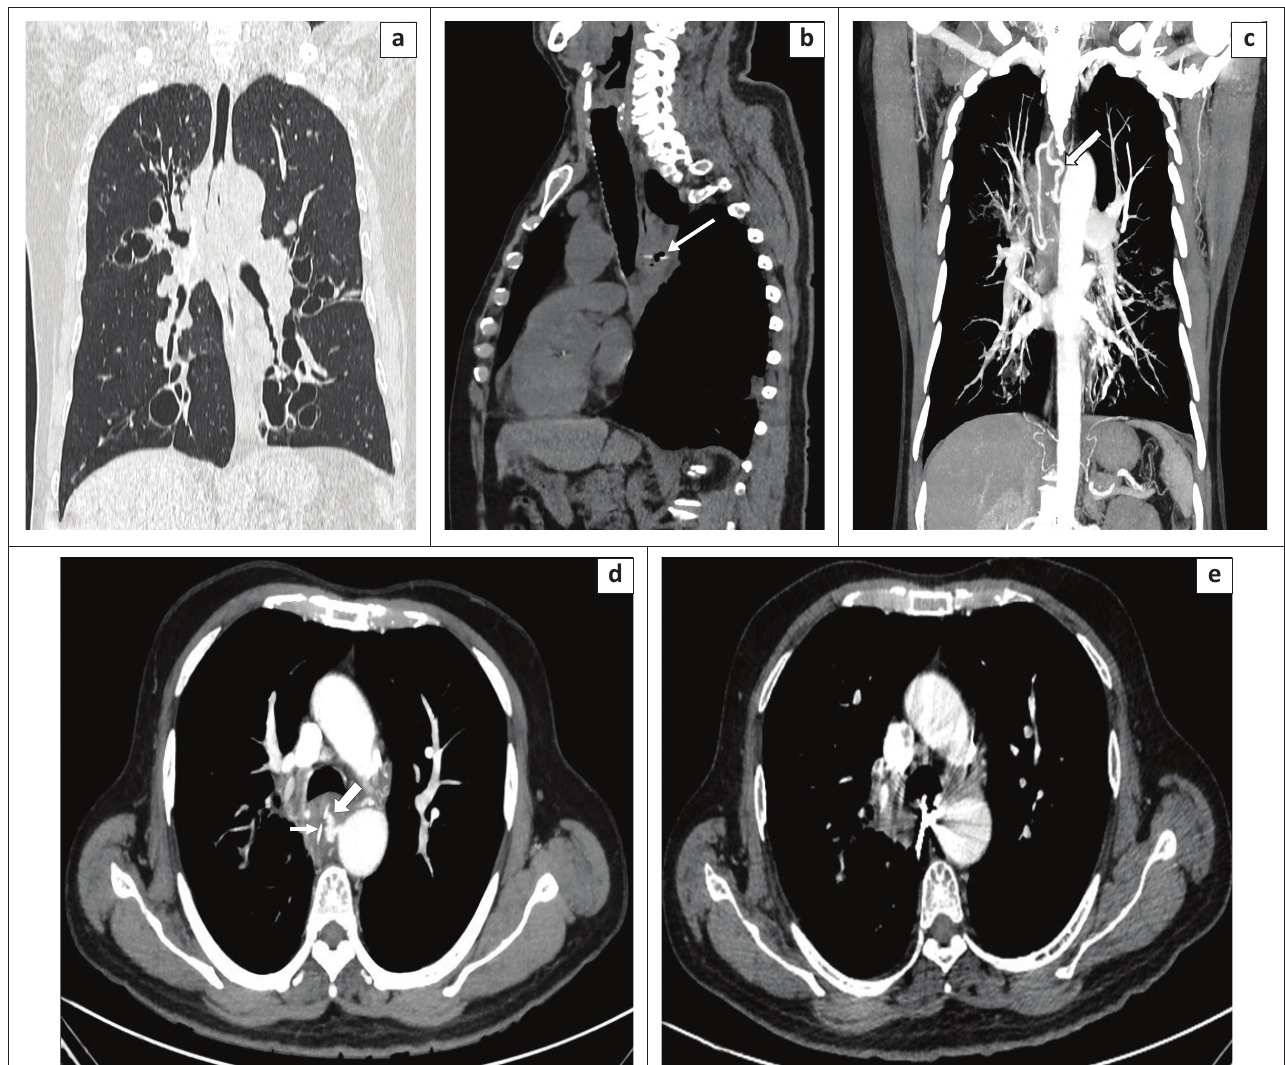
FIGURE 4: Computed tomography (CT) images of a 61-year-old man with a pseudoaneurysm of a hypertrophied bronchial artery following impaction of a retro-oesophageal fish bone (FB). Reformatted coronal CT images indicate the (a) underlying bronchiectasis (b) impacted retroesophageal FB and collection (thin arrow). (c) Post contrast 3D-multiplanar reformation (MPR) coronal image shows the hypertrophied bronchial artery (thick arrow). (d) Post contrast 3D CT axial image shows the impacted FB (thin arrow) causing a pseudoaneurysm of the hypertrophied bronchial artery (thick arrow). (e) Post embolisation of the bronchial artery pseudoaneurysm; the FB was